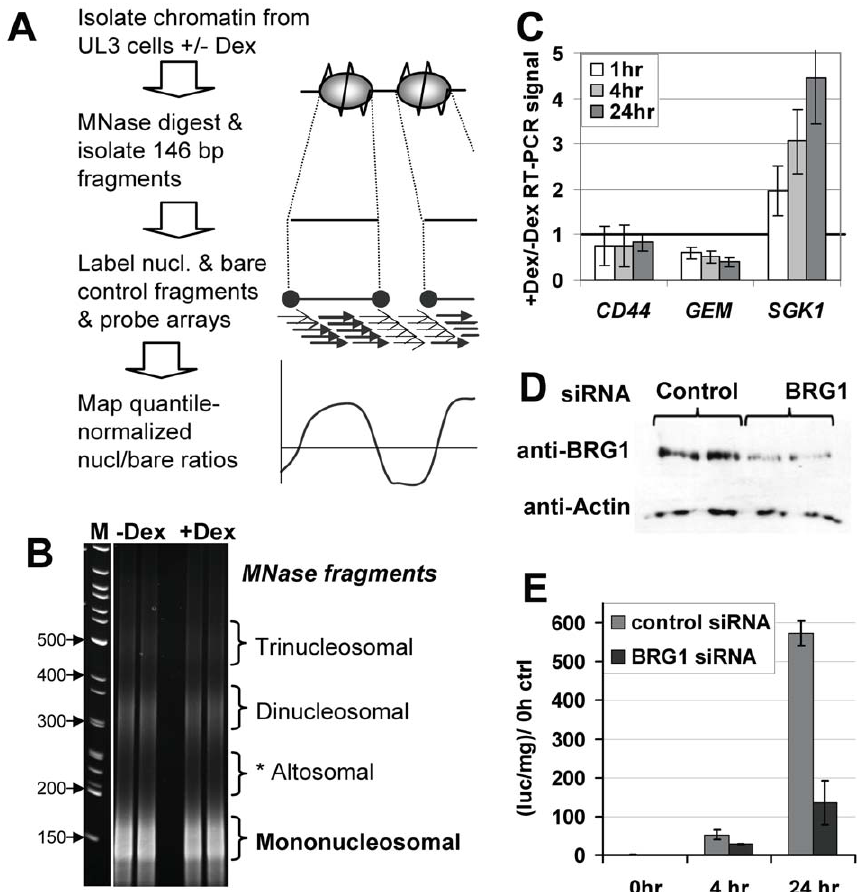
Figure 1. System for the analysis of chromatin changes during glucocorticoid treatment. ( A ) Experimental schematic. ( B ) Example of PAGE of chromatin fragments used to isolated mononucleosomal fragments (as well as altosomal fragments analyzed in Fig. S15). Complete gels and quantitation are shown in Fig. S1. ( C ) RT-PCR for mRNA levels of CD44 (control), GEM (Dex repressed) and SGK1 (Dex activated) endogenous genes. Results show the signal at the indicated time with Dex divided by the signal without Dex. ( D ) Western blot versus BRG1, using anti-actin as a control, shows transfection with BRG1 specific siRNA reduces BRG1 protein levels. ( E ) MMTV luciferase transactivation by Dex, as measured by luminometer, is attenuated in BRG1 siRNA transfected cells.